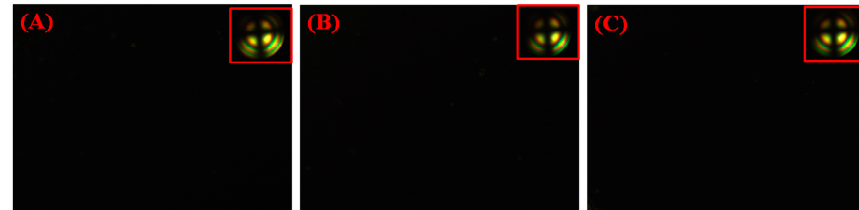
Figure 3. POM microphotographs of LC cells with 2 wt % DA monomers ( A ), 1 wt % DA monomers ( B ), and 0.5 wt % DA monomers ( C ) after UV irradiation and thermal annealing at 120 °C for 30 min.